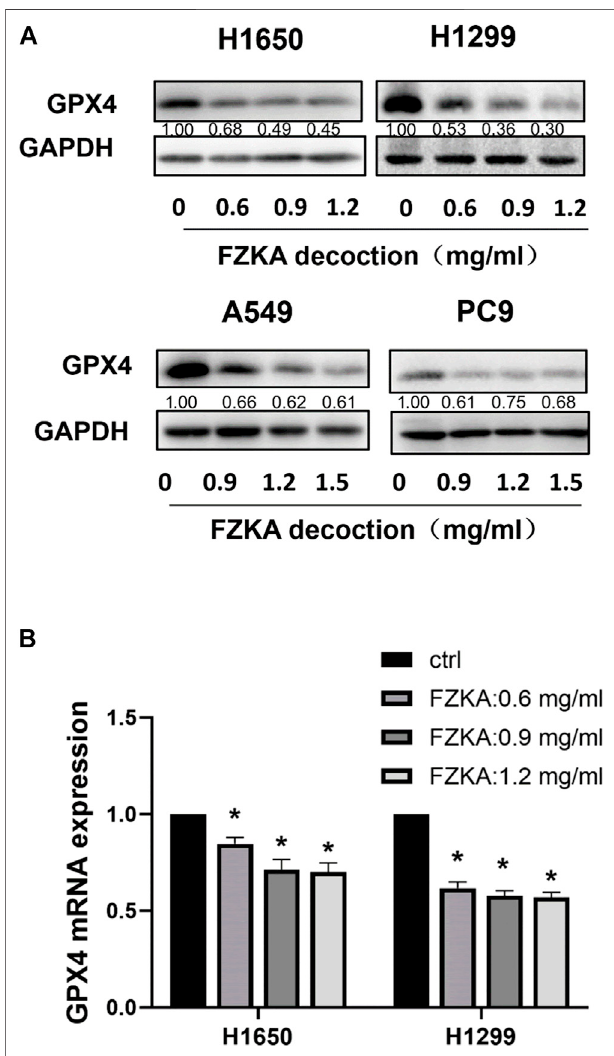
FIGURE 4 | FZKA downregulated the GPX4 expression in NSCLC cells at both protein and mRNA levels. (A) , The protein expression levels of GPX4 were detected by Western blot. (B) , NSCLC cells were treated with different concentrations of FZKA for 24 h. The mRNA expression of GPX4 were detected by qPCR. Each point represents the mean ± SEM, n = 3. * p <